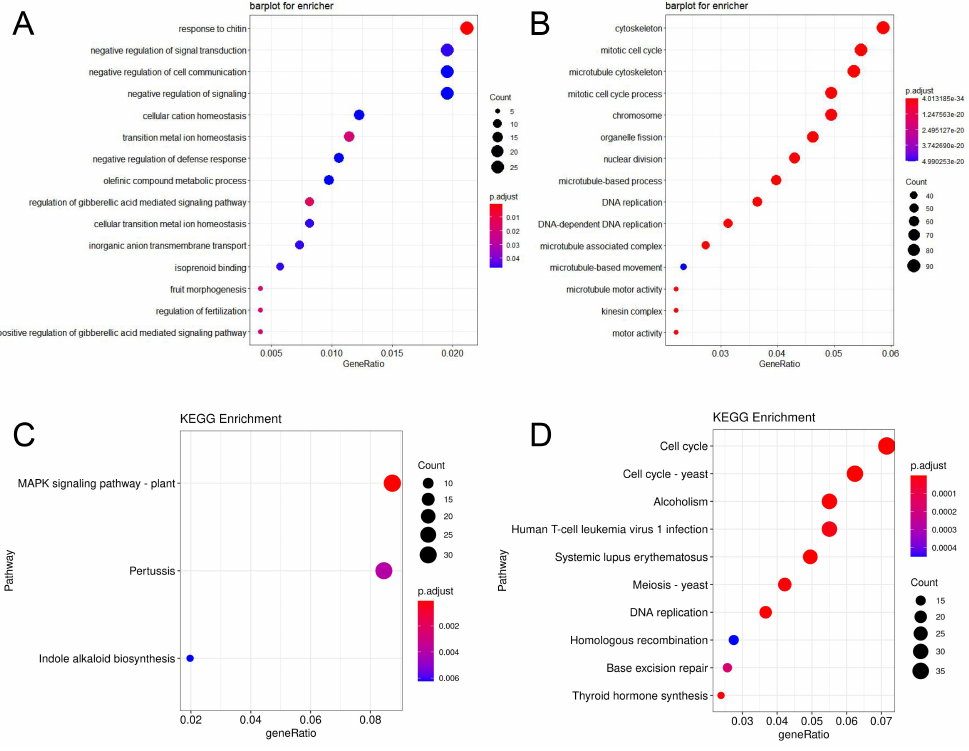
Figure 3. Enriched GO and KEGG of up-regulated DEGs in ‘BX’ and ‘RK’. ( A ) GO enrichment terms of up-regulated DEGs in ‘BX’; ( B ) GO enrichment terms of up-regulated DEGs in ‘RK’; ( C ) KEGG enrichment of up-regulated DEGs in ‘BX’; ( D ) KEGG enrichment of up-regulated DEGs in ‘RK’. The sizes of points represent the numbers of